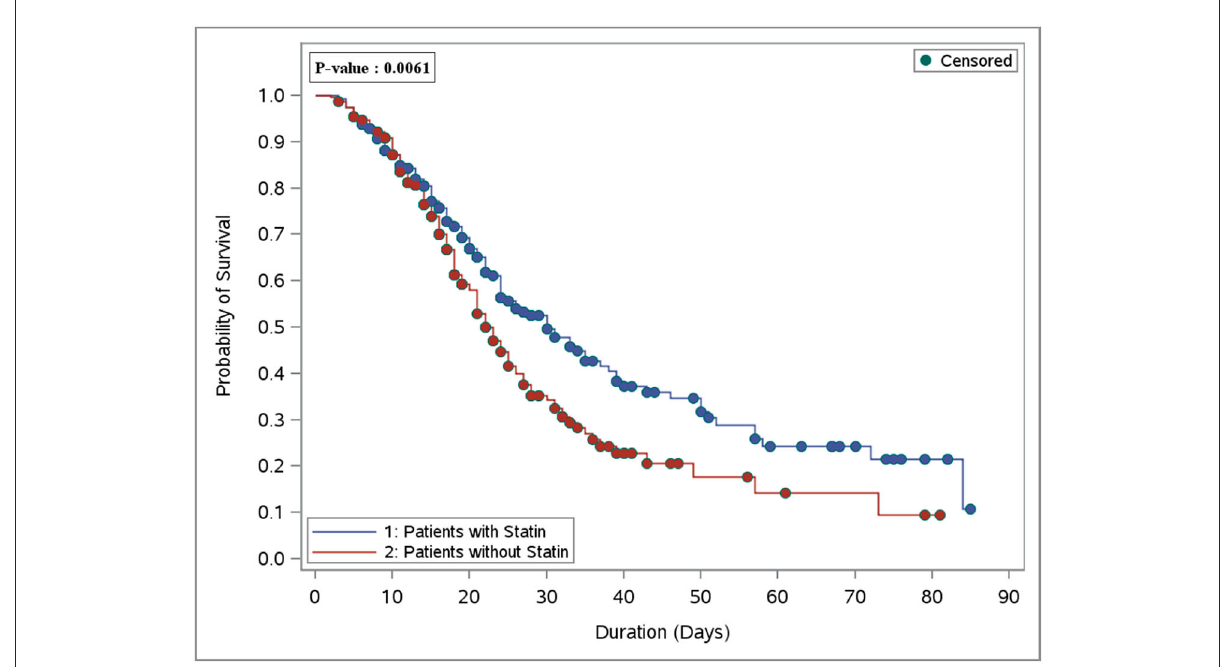
FIGURE2 Overall survival plot during the hospital stay after PS matching comparing patients who received statin therapy (251 patients) vs. the control group (non-statin; 251